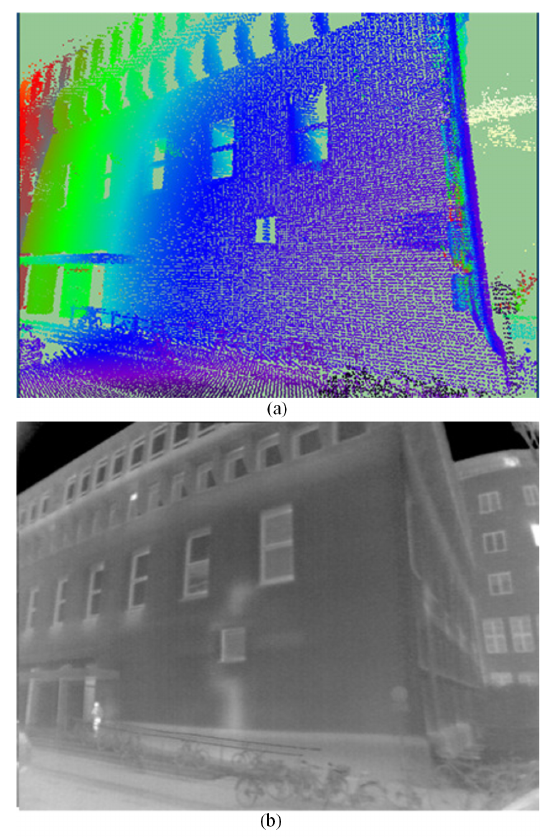
Figure 8. Pose estimation. (a) Range image generated by the point cloud and computed camera pose(the color if related to the depth of the point to the image plane). (b) Corresponding rectified